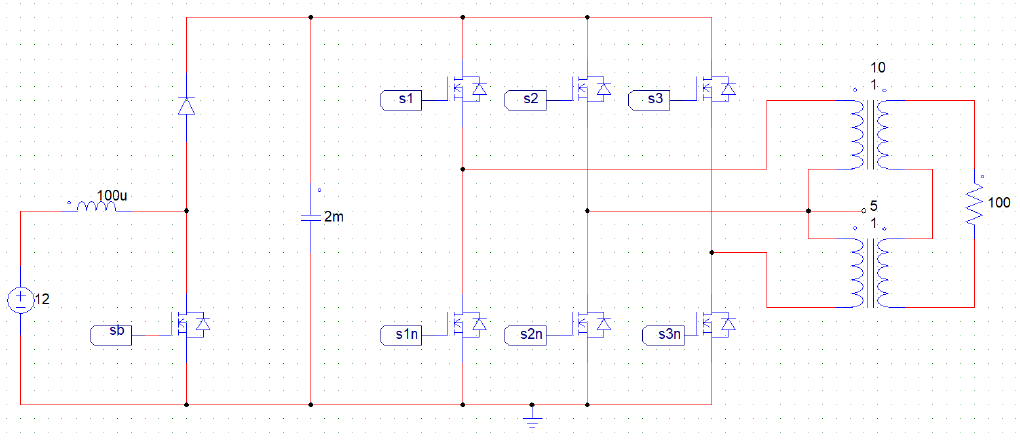
Figure 22. Schematic of the proposed inverter in the simulation program PSIM.